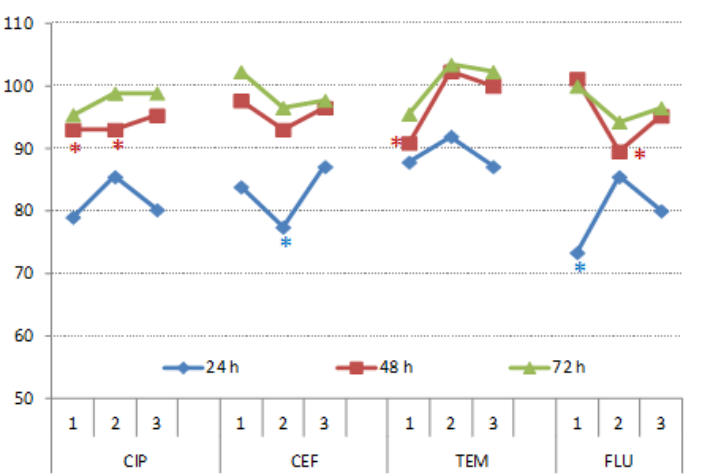
Figure 11. Germination of wheat under CIP, CEF, TEM and FLU treatments recorded after 24, 48 and 72 h. The results were expressed relatively to respective controls (control = 100%). Values with asterisks are significantly different from respective controls.